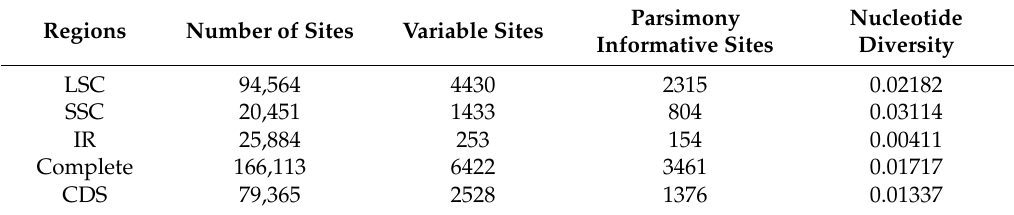
Figure 8. Sliding window analysis of the entire cp genome of seven Aristolochia species (window length: 600 bp; step size: 200 bp). X -axis: position of the midpoint of a window; Y -axis: nucleotide diversity of each window.